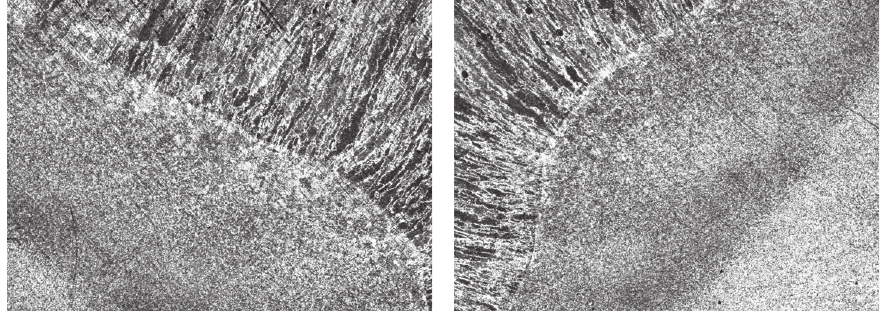
Figure 11: Details of the HAZ in TempCore ® welding. Note the increase of the grain size in HAZ in correspondence of the external martensitic layer.